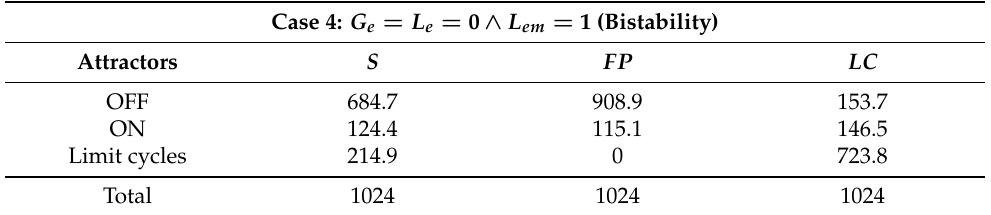
Table 3. Average size of the attraction basin for case 4 of the original model (Section 3.2) and calculated over the set S 10 , FP ⊆ S (set of update schedules whose dynamic have only steady states) and LC ⊆ S (set of update schedules whose dynamic have limit cycles). Its respective sizes are